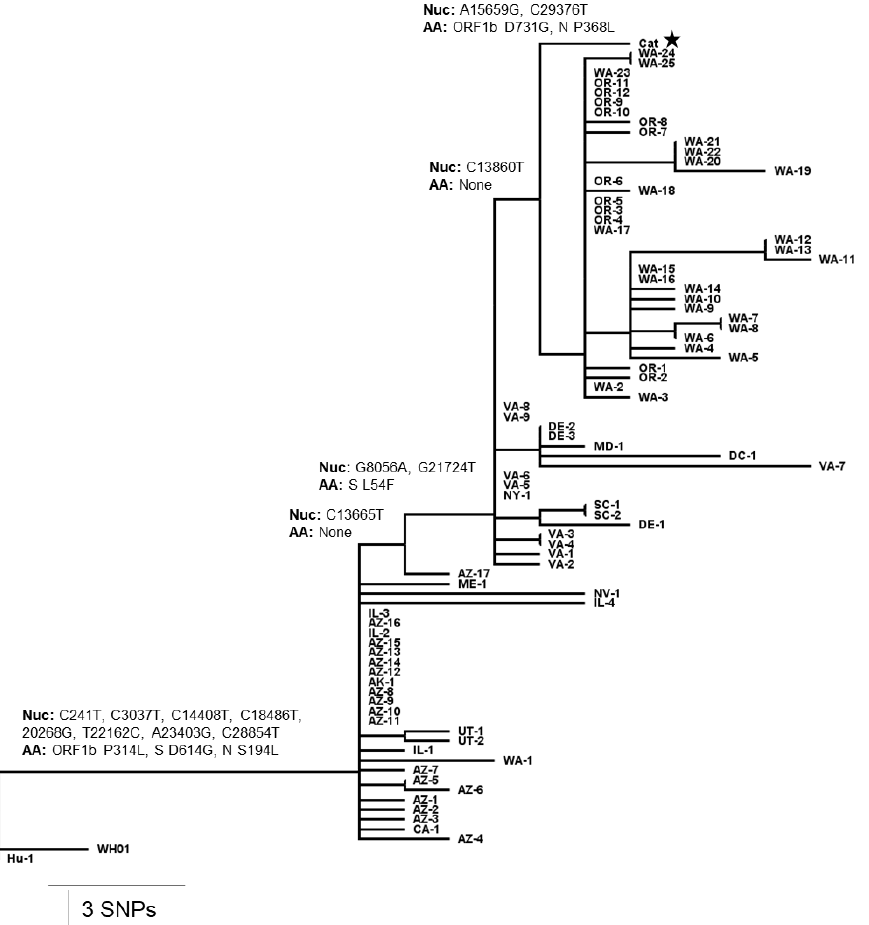
Figure 5. Phylogenetic placement of SARS-CoV-2 obtained from the infected cat. Phylogenetic tree with branches scaled by genetic divergence, with SNPs and amino acid changes labeled on branches leading to the cat sample. Additional sequences, labeled by their state of origin were selected by genetic proximity to the cat sequence from the pool of sequences matching the pangolin B.1.240 lineage. Wuhan/Hu-1/2019 and Wuhan/WH01/2019 were included for rooting. Full names of the included sequences are given in Tables S1 and